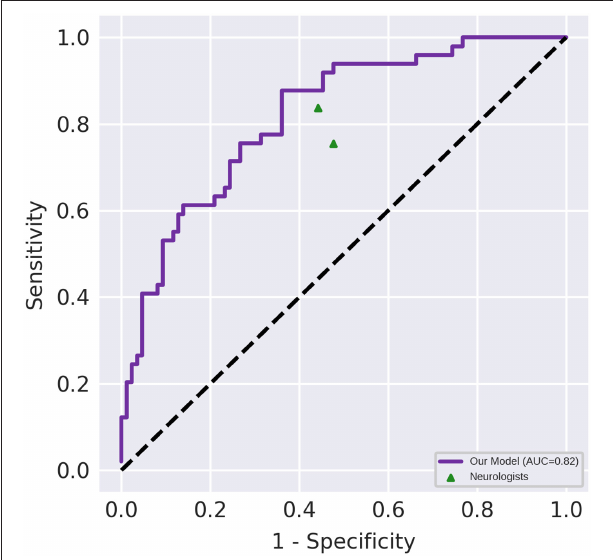
FIGURE 3 | Diagnostic performance of the deep learning-based model and the neurologists. Performance on an independent test set with n = 135. The area under the receiver operating characteristic (AUC) of the proposed model (represented by the violet line) was 0.82 (95% CI, 0.75–0.89). The points correspond to the performance of the